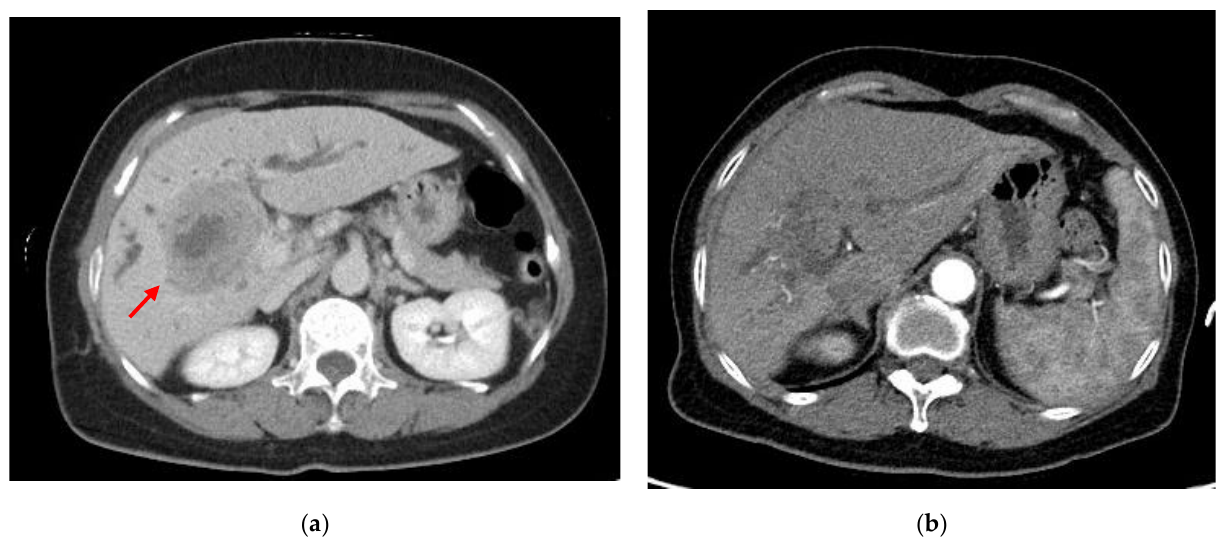
Figure 1. Abdominal computed tomography with contrast medium. ( a ) Scan shows a 5.8-cm lobulated soft-tissue mass with central necrosis in segment 6 of the liver (arrow); ( b ) scan after chemotherapy.